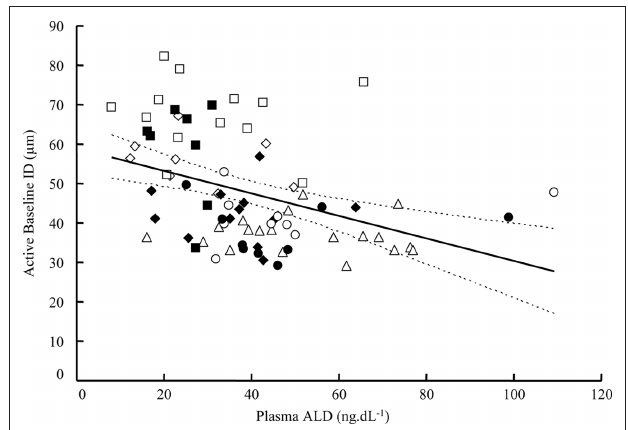
FIgure 3 | relationship between cerebral arteriolar diameter and aldosterone level. Relationship between aldosterone (ALD) plasma level and cerebral arteriolar internal diameter in WKY-solvent (open square), WKY-ALD (full square), SHR-solvent (open triangle), SHR-ARB (open circle), SHR- ARB + ALD (full circle), SHR-ACEI (open lozenge), and SHR-ACEI + ALD (full lozenge). Pooled n = 78. Linear regression equation: Y = − 0.29 X + 59; r 2 = 0.161; degrees of freedom = 76 ( P